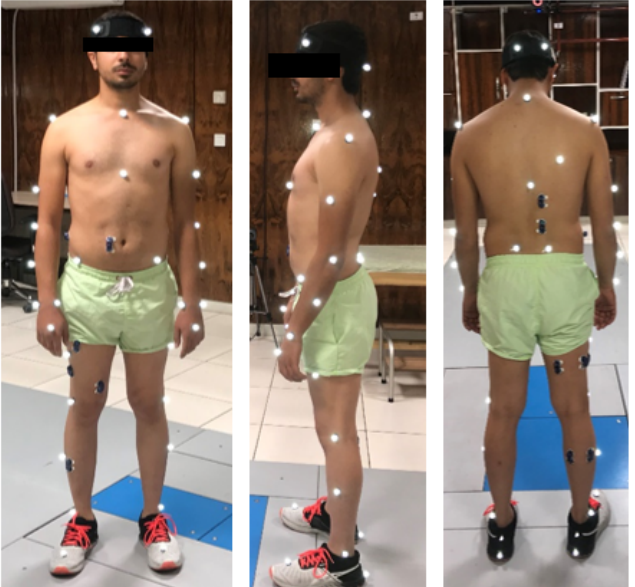
Figure 1. Experimental setup used for GAIT measurements. The motion analysis lab for kinematics and kinetics measurements in Movafaghian (Sharif University of Technology, Tehran, Iran) consists of high-speed motion captures and force